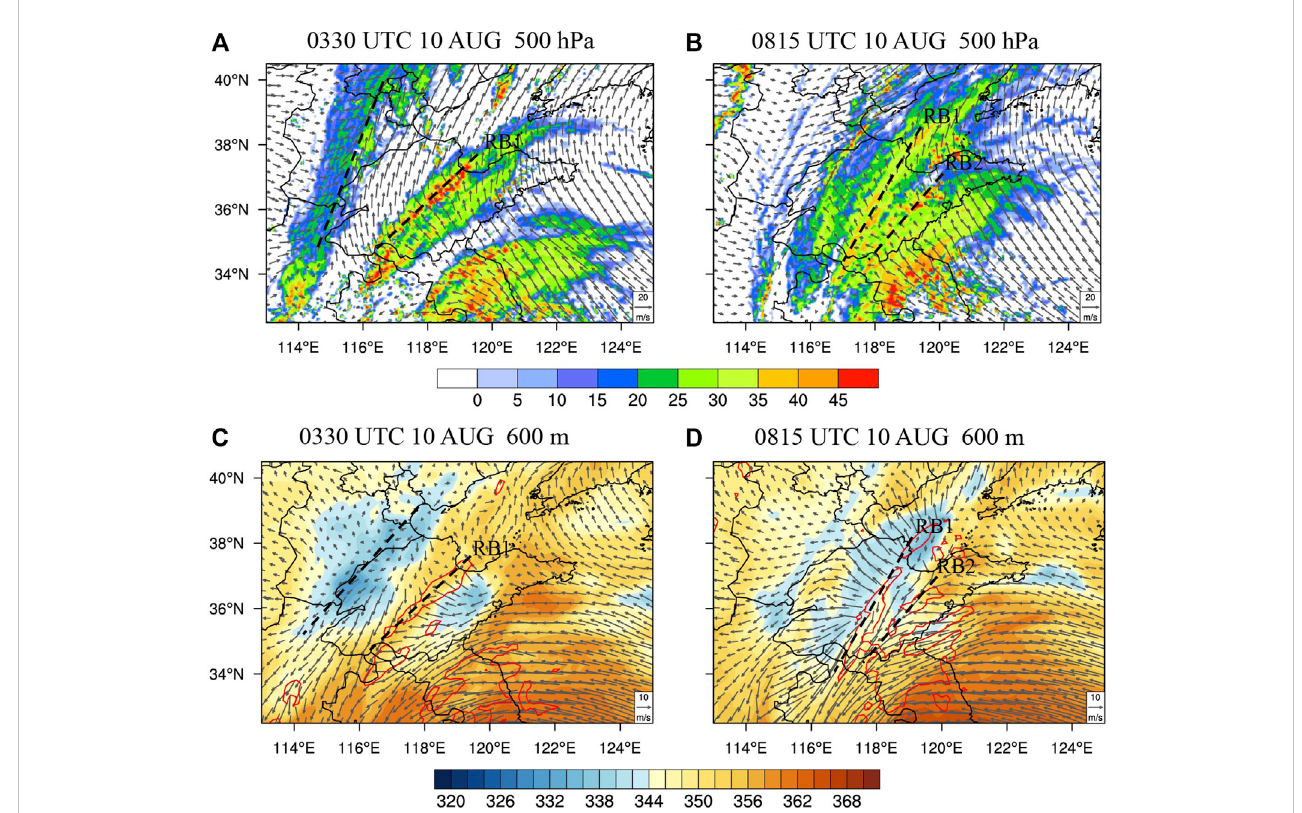
FIGURE 9 For 0330 UTC 10 August 2019, (A) composite re fl ectivity (shaded; unit: dBZ) and 500-hPa horizontal winds (vectors, unit vector represents 20 m/s); (C) 600-m-equivalent potential temperature (shaded; unit: K), horizontal winds (vectors, unit vector represents 10 m/s), and 32-dBZ composite re fl ectivity (red contours) from the D02 simulation. (B) and (D) as in (A) and (C) , but at 0815 UTC 10 August. Black dashed lines indicate the positions of the